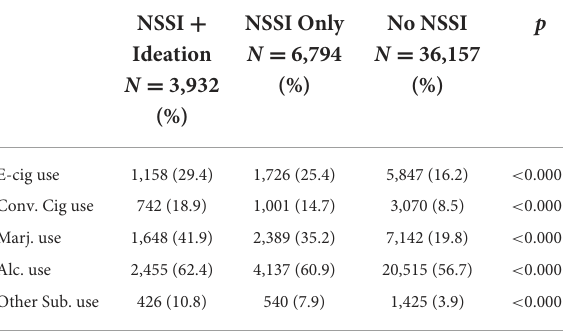
TABLE 3 Substance use behavior, by past 12-month NSSI AND suicidal ideation ( N =